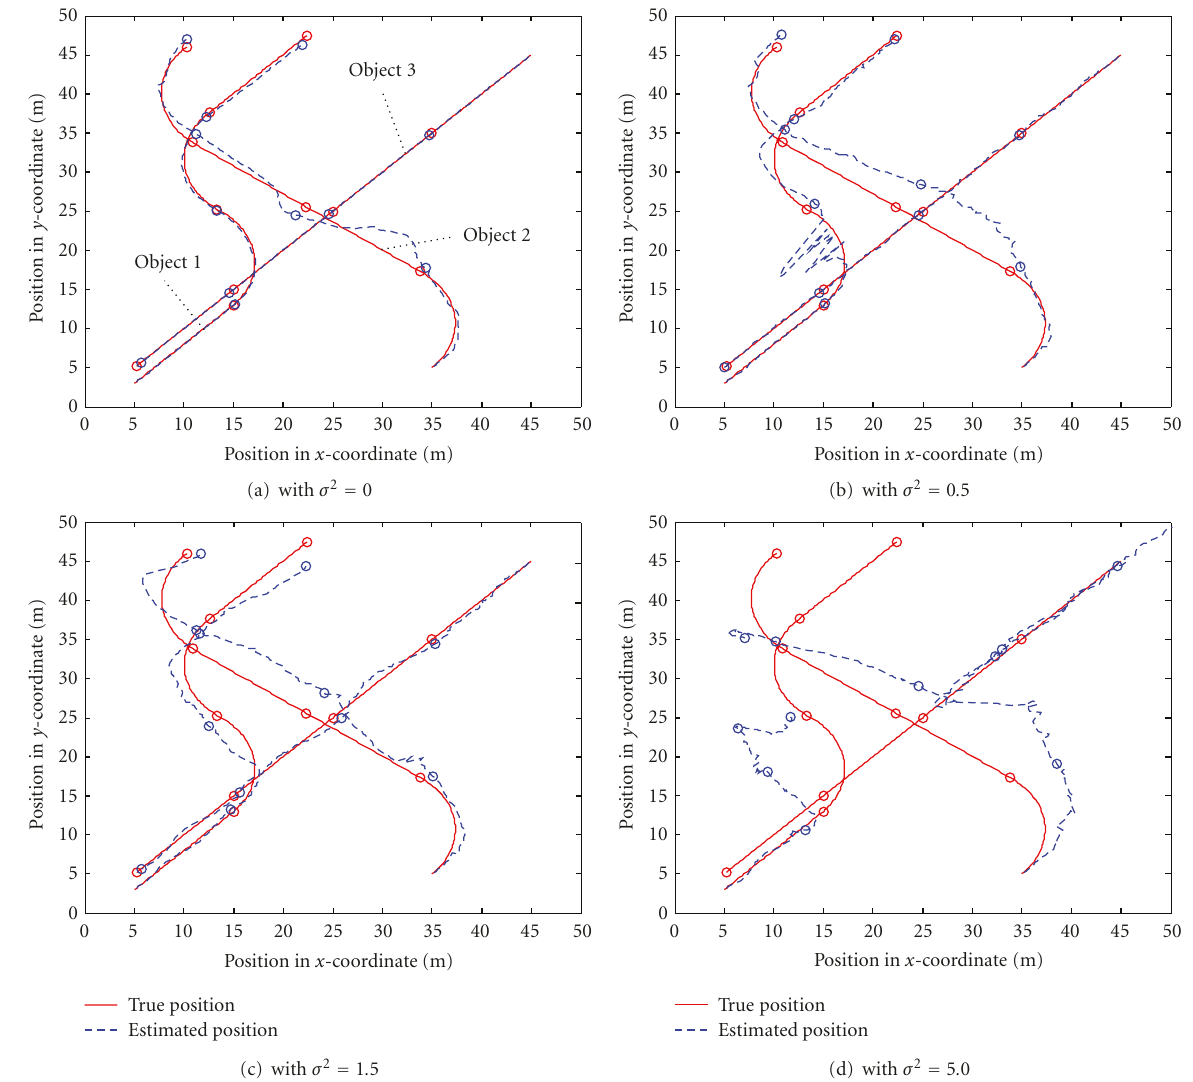
Figure 3: The estimation only with an acoustic sensor for various measurement noise variances σ 2 : 0, 0.5, 1.5, and 5.0.